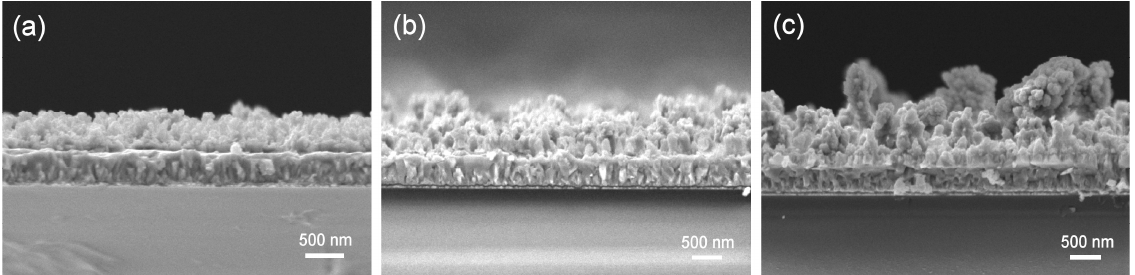
Figure 5. Cross-section SEM images of electrodeposited CuFeO 2 film with an applied current density of − 0.1 mA cm − 2 in DMSO based electrolyte containing 1 mM Cu(NO 3 ) 2 · xH 2 O/3 mM Fe(ClO 4 ) 3 ∙ xH 2 O/100 mM potassium perchlorate for different deposition time: ( a ) 20 min ( b ) 40 min and ( c ) 60 min. Samples were annealed at 650 °C for 1 h under N 2 gas flow after electrodeposition.